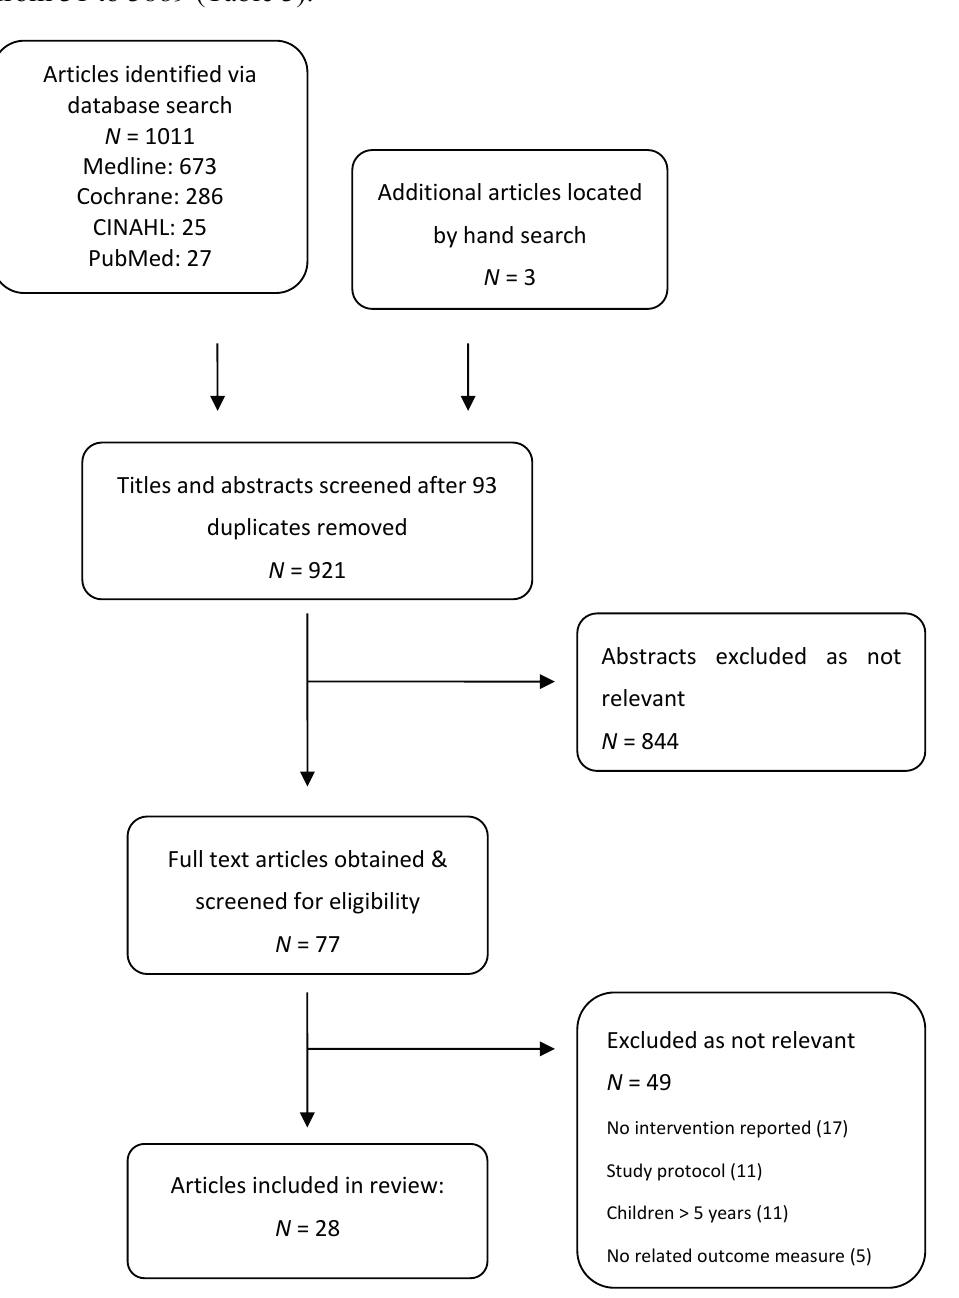
Figure 1. Search